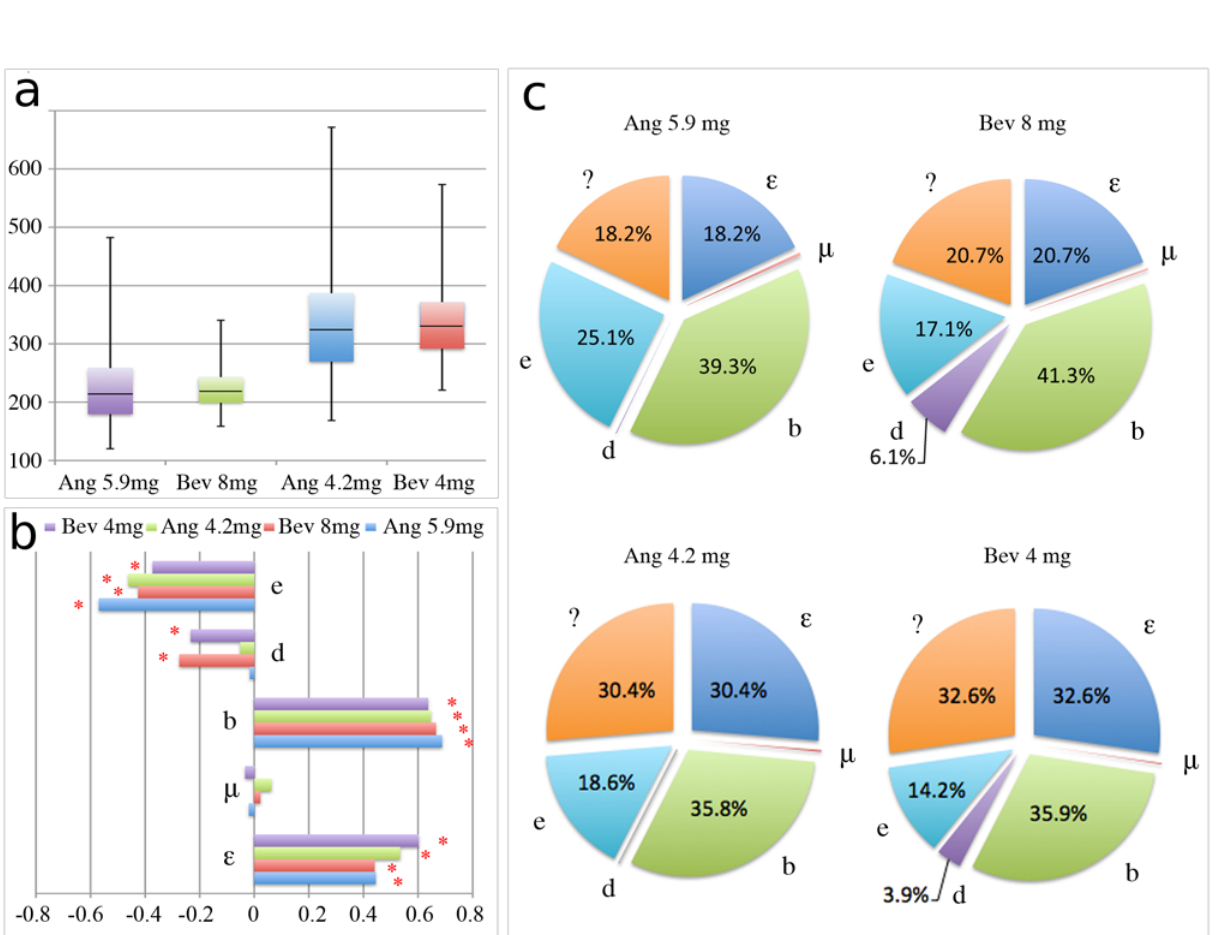
Fig 3. Global sensitivity analysis for Bevacizumab and Angiostatin. Analysis carried for two different dose regimes and with the nominal parameters values presented in Table 1 and Table 2. ( a ) Box plot of tumor volume after 26 days from the initiation calculated from 1,000 samples generated under the assumption that parameters ε , μ , b , d , e are varied uniformly up to 20%. ( b ) Partial rank correlation coefficients between each parameter and the tumor volume after 26 days from initiation ( * denotes p-value below 0.01). ( c ) First order sensitivity indices, defined as the fraction of the total variance in tumor volume caused by the variation in each parameter value. Calculations were performed after 26 days from tumor initiation using the FAST